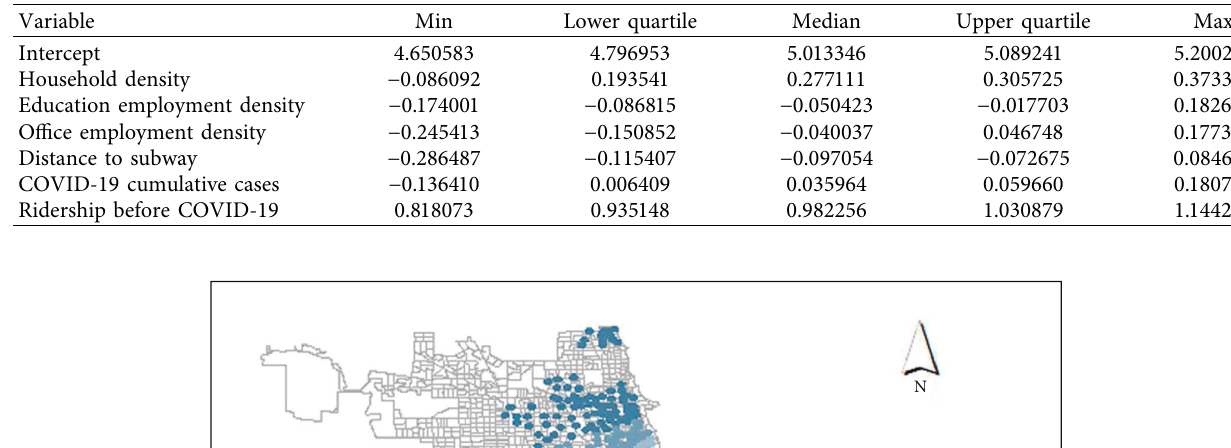
Table 5: Coefficients of each variable in the GWR model.